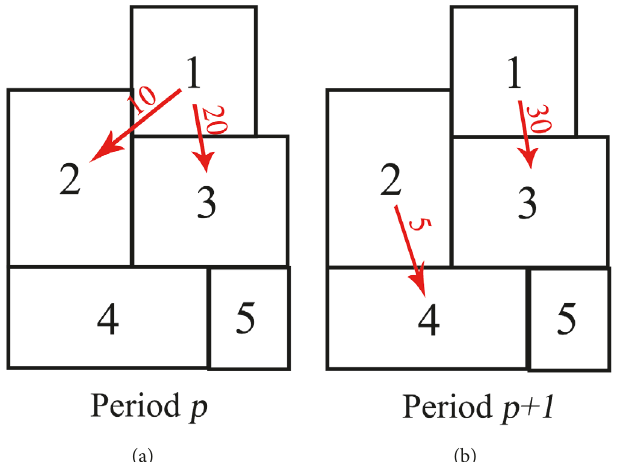
Figure 2: Examples of the change of a taxicab’s operation zones. The rectangles represent TAZs and each TAZ is given a unique ID ranging from 1 to 5. A red arrow represents this taxicab has completed trips from the start TAZ of the arrow to the end TAZ of the arrow. In addition, the trip number is given beside the arrow in red number. The change of taxicab operation zones between neighboring periods can be derived by comparing the taxicab operation zones in current period (a) and taxicab operation zones in next period